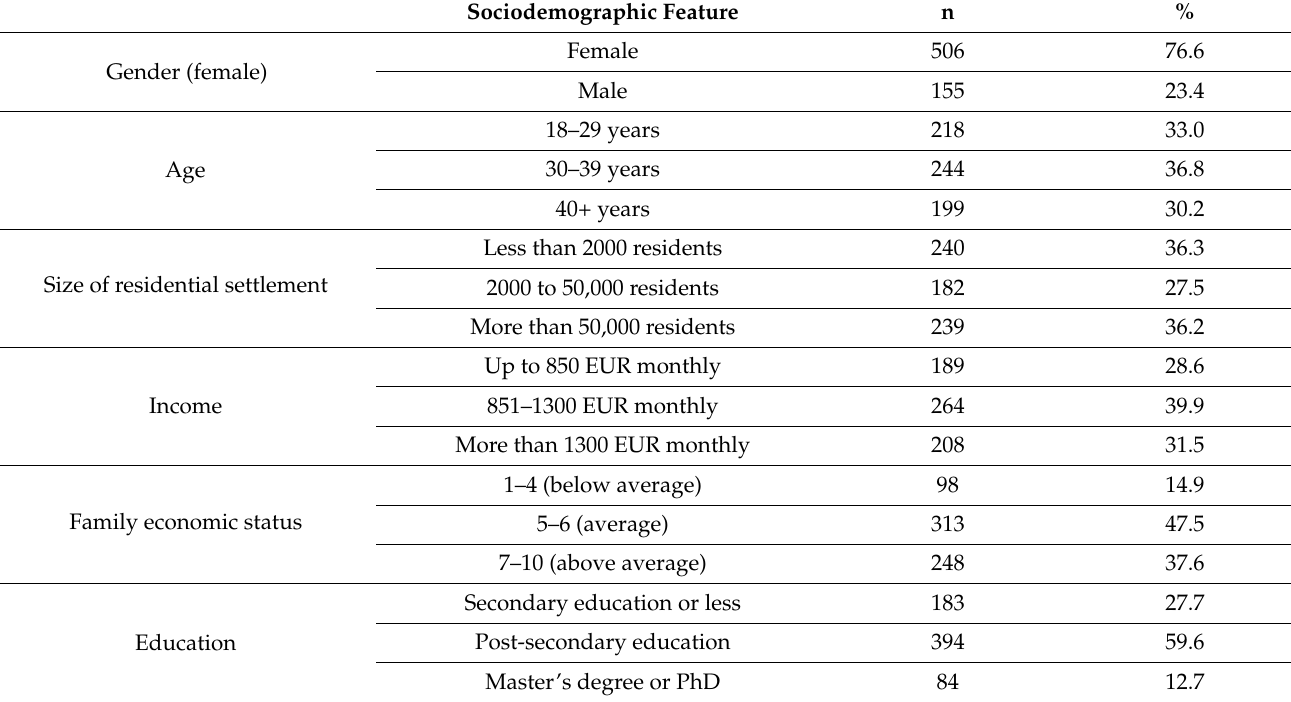
Table 1. Descriptive statistics of vaccine attitudes, cultural capital and control